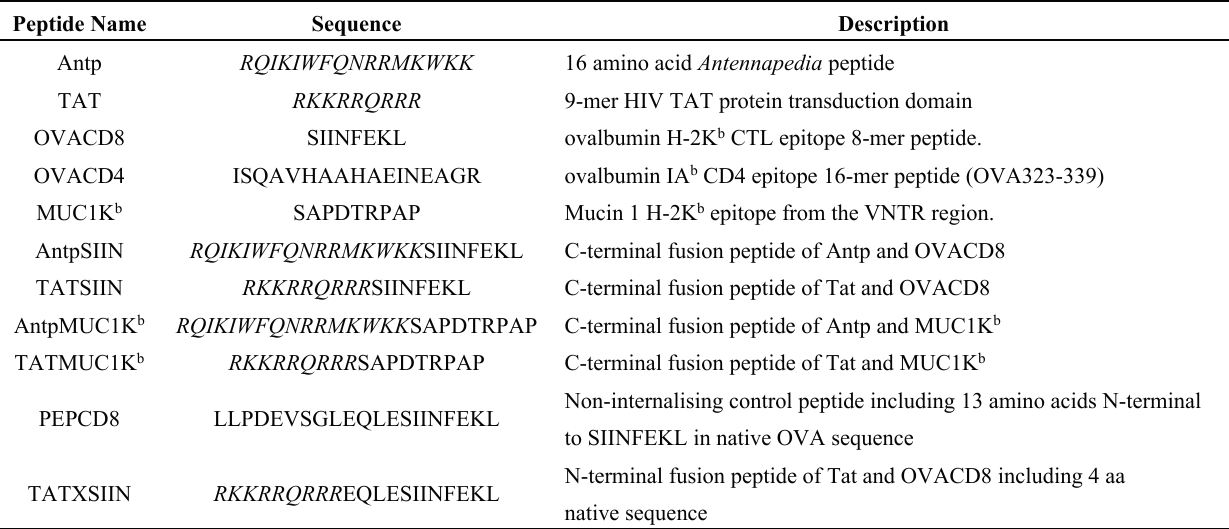
Table 1. Synthetic peptides used in the